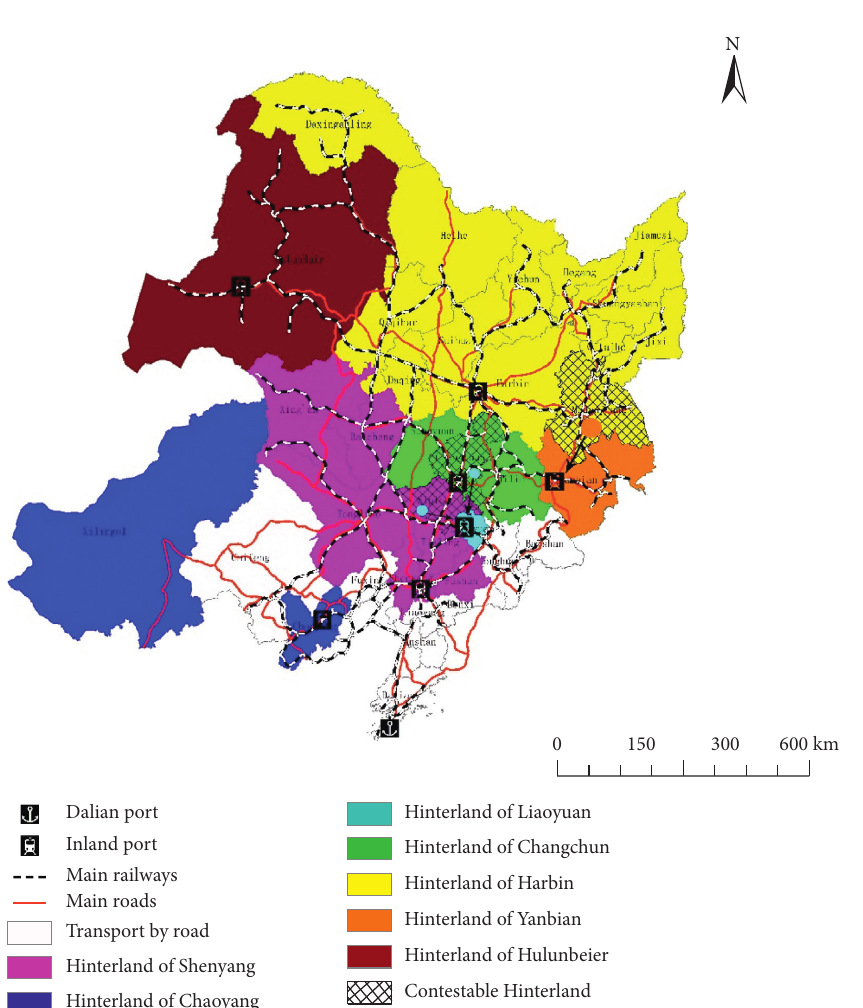
Figure 2: Hinterland area of the dry port under the road-rail-road mode.